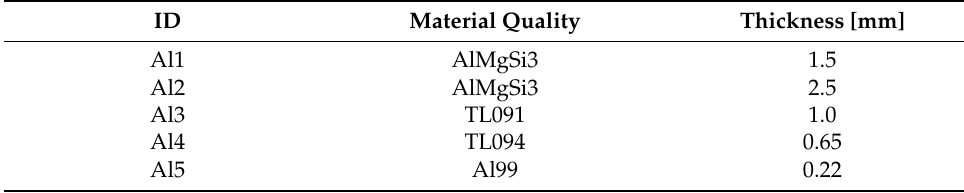
Table 3. Aluminum sheet materials used for painting tests.